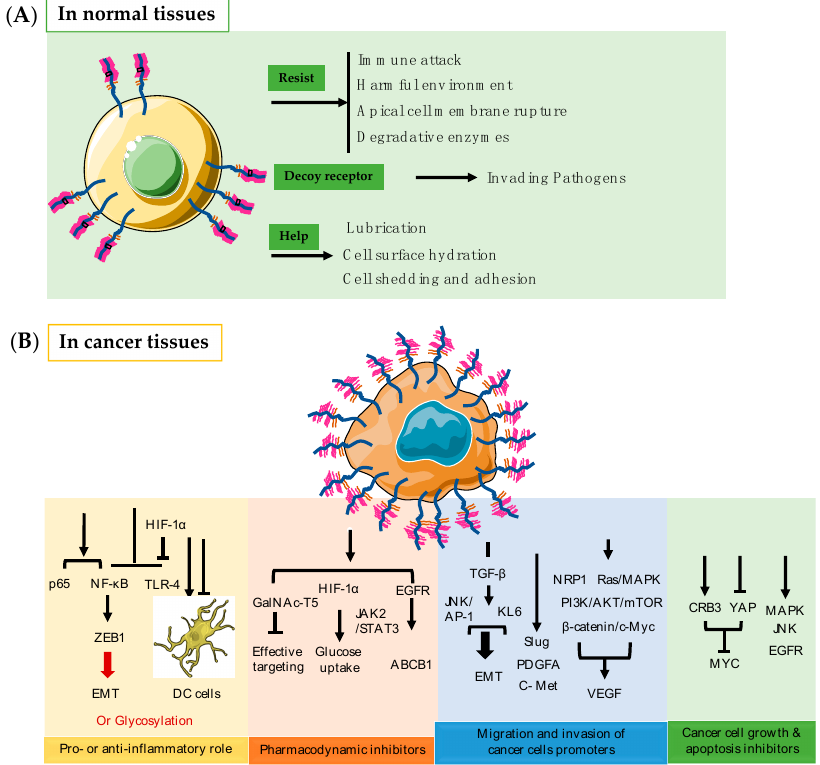
Figure 2. Different function of MUC1 in health or cancer tissues. ( A ) The function of MUC1 in normal tissues; ( B ) The function and its main pathways of MUC1 in cancer tissues.